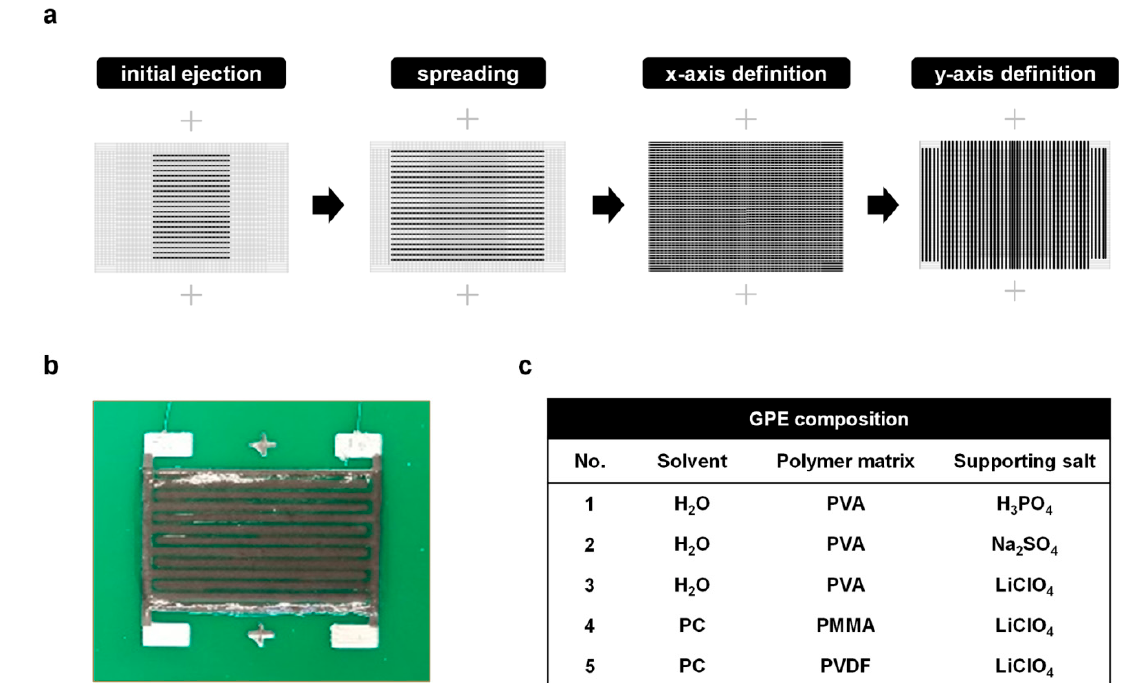
Figure 1. Fabrication process and results. ( a ) Pattern structures of the four-step electrolyte ink printing. The light gray area represents the entire pattern, while the black lines show the nozzle paths of the specific printing step. ( b ) Top-view image of the all-printed supercapacitor with the printed gel-polymer electrolyte (GPE). ( c ) Composition of the GPE formulations used in the experiments. Concentrations of the salts are 0.5 M and the molar ratio of polymer matrix and supporting salt is 3:1.